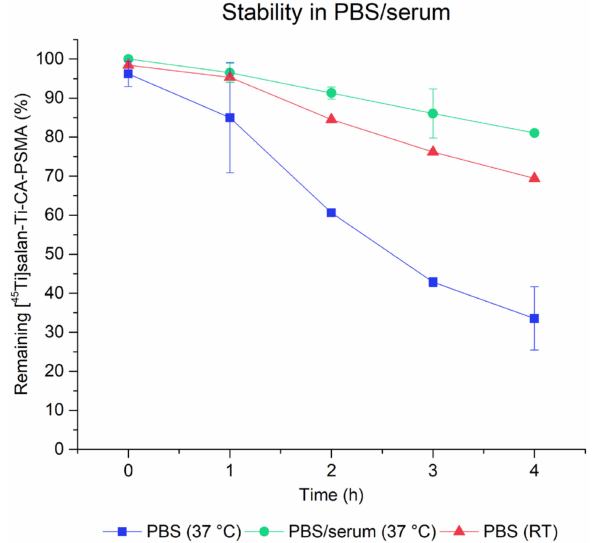
Figure 3. The stability of [ 45 Ti]salan-Ti-CA-PSMA ([ 45 Ti]- 3 ) in PBS bu ff er at 37 ◦ C ( blue squares ) and at room temperature ( red triangles ) and in PBS / mouse serum 1 / 1 ( v / v ) at 37 ◦ C ( green circles ). The [ 45 Ti]salan-Ti-CA-PSMA was quantified by radio-TLC using nonradioactive salan-Ti-CA-PSMA ( 3 ) as reference